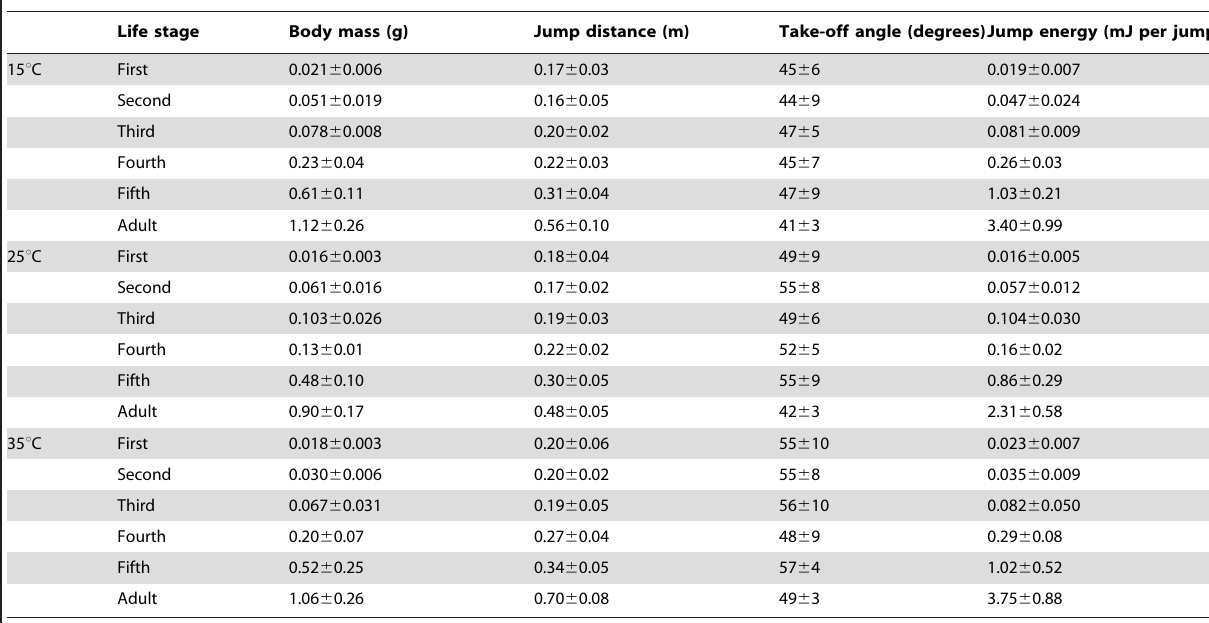
Table 1. Effects of life stage and temperature on jump performance of Locusta migratoria .